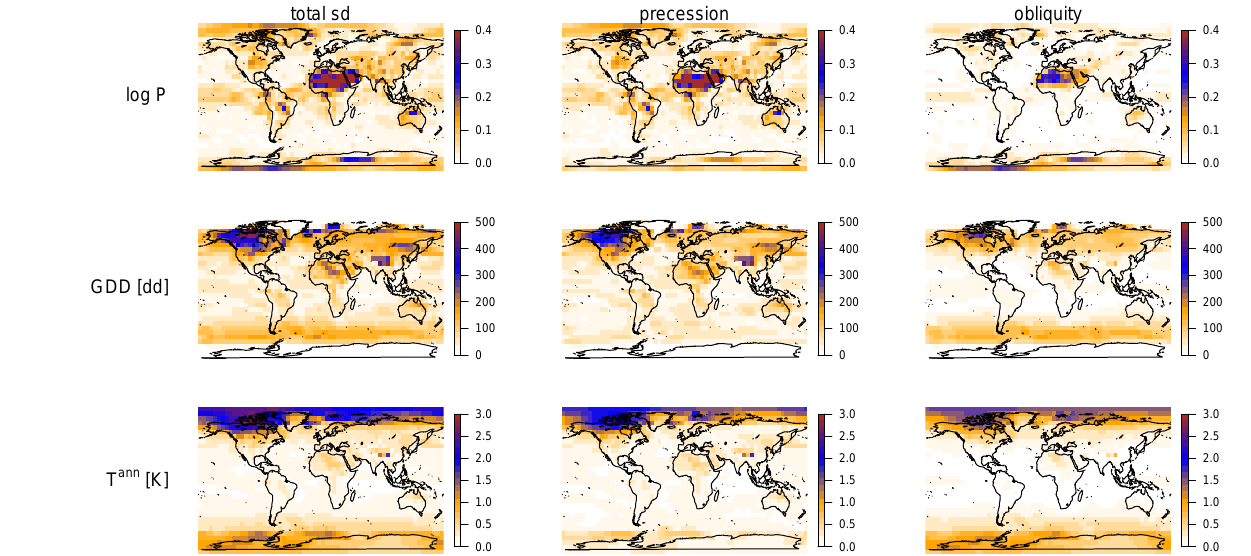
Figure 7. Geographical distribution of total variance V , split into contributions from precession T { (cid:36) } and obliquity T ε